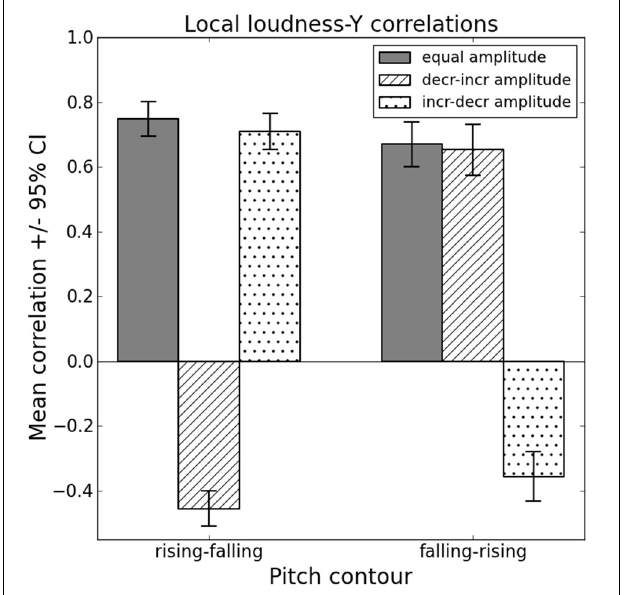
FIGURE 4 | Spurious loudness vs. height association: influence of interaction between pitch and loudness contour on local loudness–Y